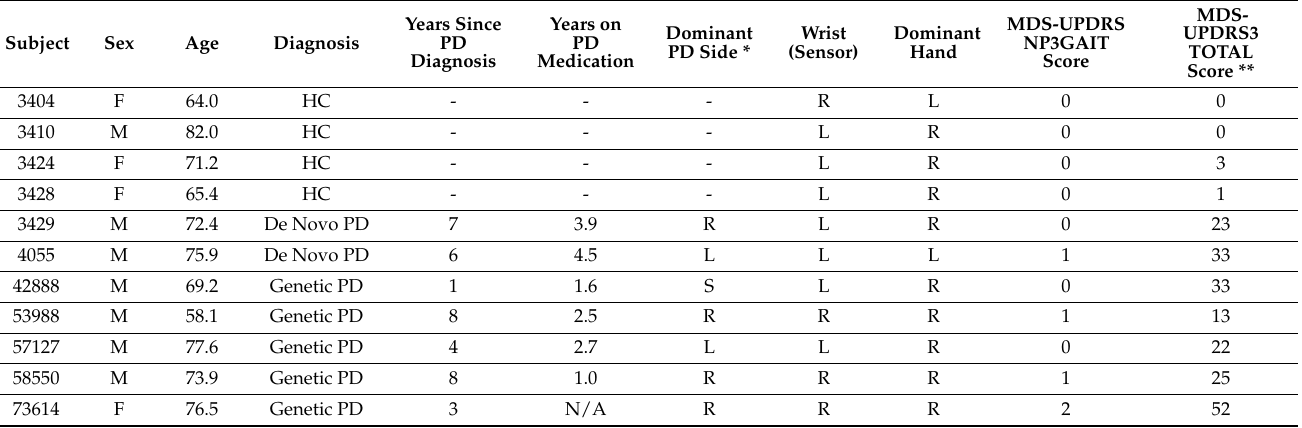
Table 1. PPMI participant